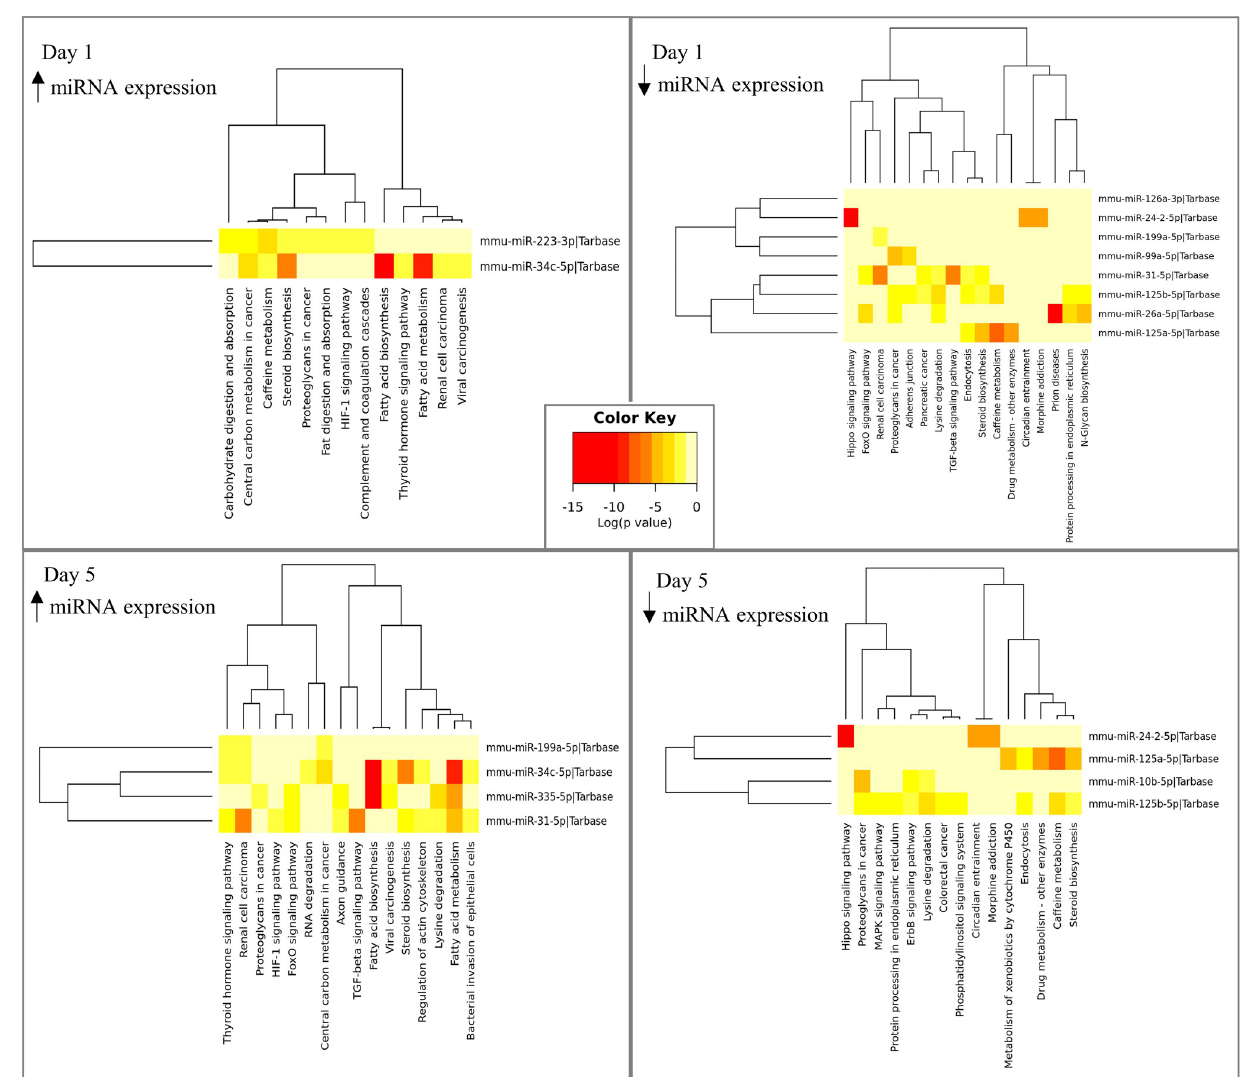
Fig 3. Analysis of the miRNAs expression. Heatmap of KEGG pathways referring to increased or decreased expression of miRNAs at different times of analysis.